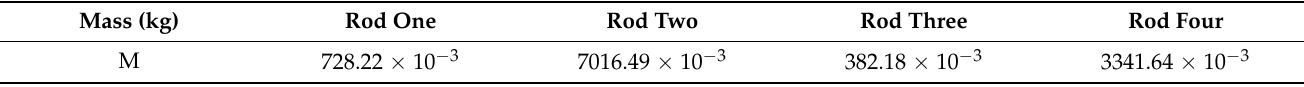
Table 3. Mass of connecting rod of the humanoid manipulator.